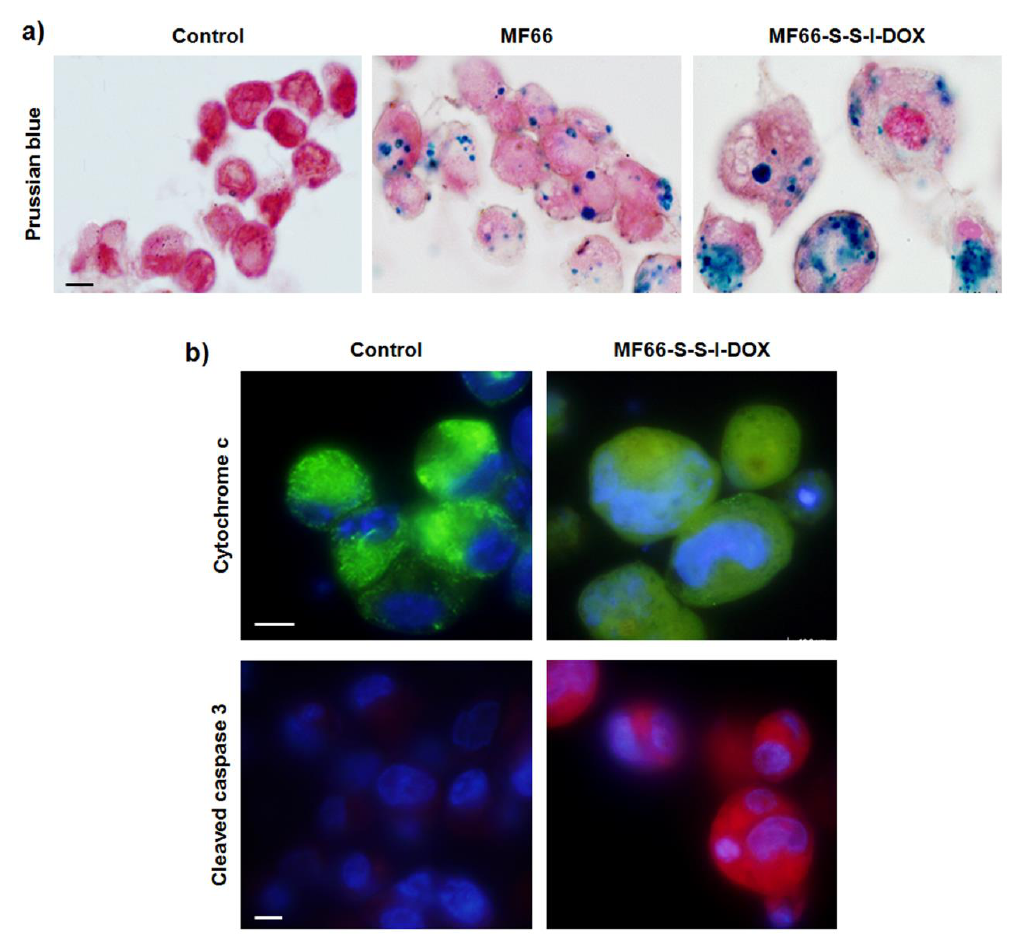
Figure 7. Morphological characterization and cell death mechanism triggered in mammospheres from MDA-MB-231 cells. ( a ) Prussian blue staining in control cells or treated with MF66 or MF66-S-S-I-DOX MNPs and visualized by bright field microscopy. Scale bar: 5 µ m. ( b ) Immunofluorescence for cytochrome c (green) and DNA staining (blue) visualized by fluorescence microscopy. Scale bar: 5 µ m. ( c ) Immunofluorescence for cleaved caspase 3 (red) and DNA staining (blue) visualized by fluorescence microscopy. Scale bar: 5 µ